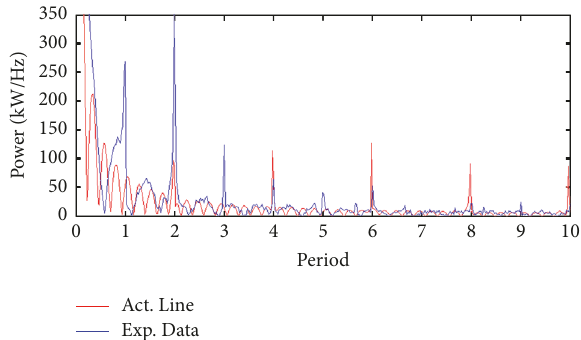
Act. Line Exp. Data Figure 5: Output power spectrum for 𝑈 ∞ = 7